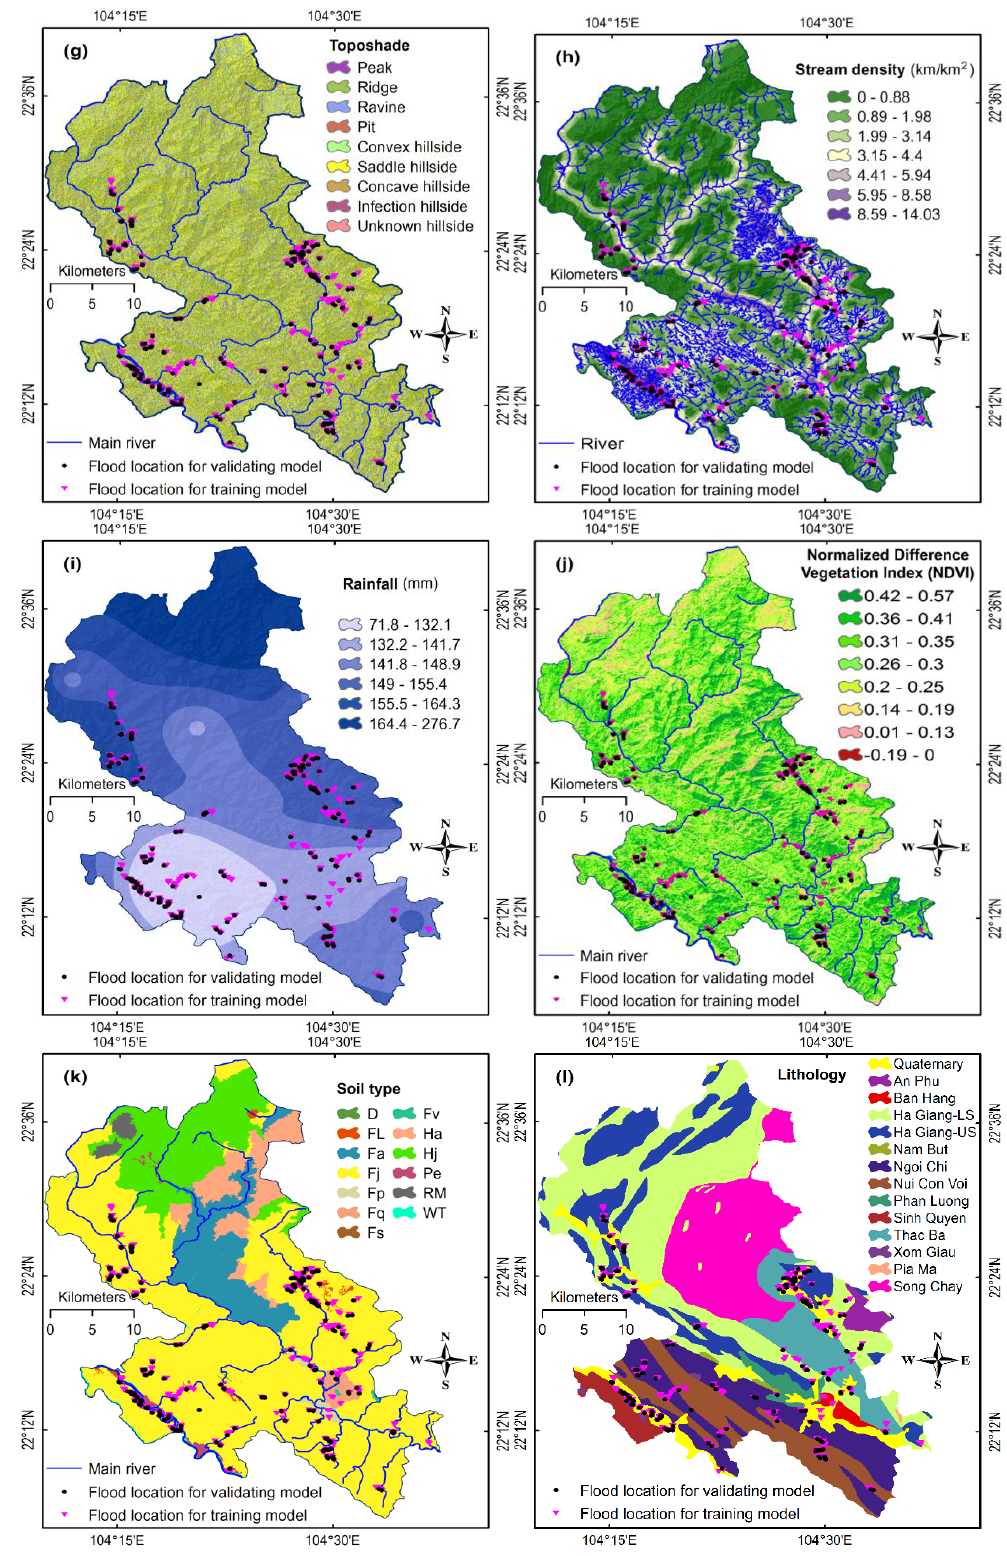
Figure 7. Flash flood conditioning factors: ( a ) elevation; ( b ) slope; ( c ) aspect; ( d ) curvature; ( e ) Topographic Wetness Index; ( f ) Stream Power Index. Flash flood conditioning factors: ( g ) toposhade, ( h ) stream density; ( i ) rainfall; ( j ) Normalized Difference Vegetation Index; ( k ) soil type; and ( l ) lithology.